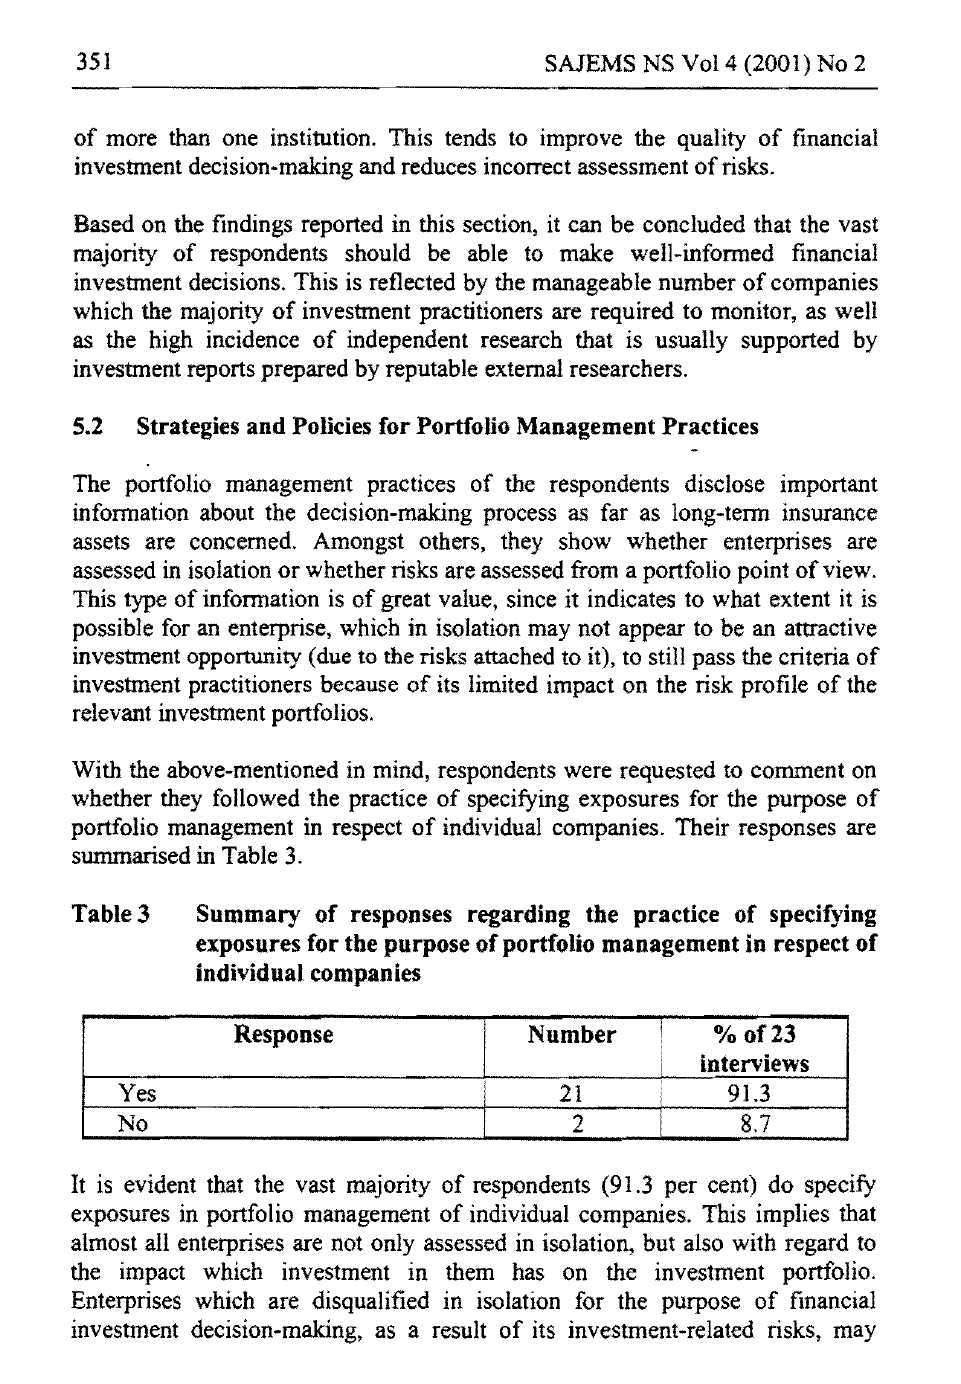
Summary of responses regarding the practice of specifying exposures for the purpose of portfolio management in respect